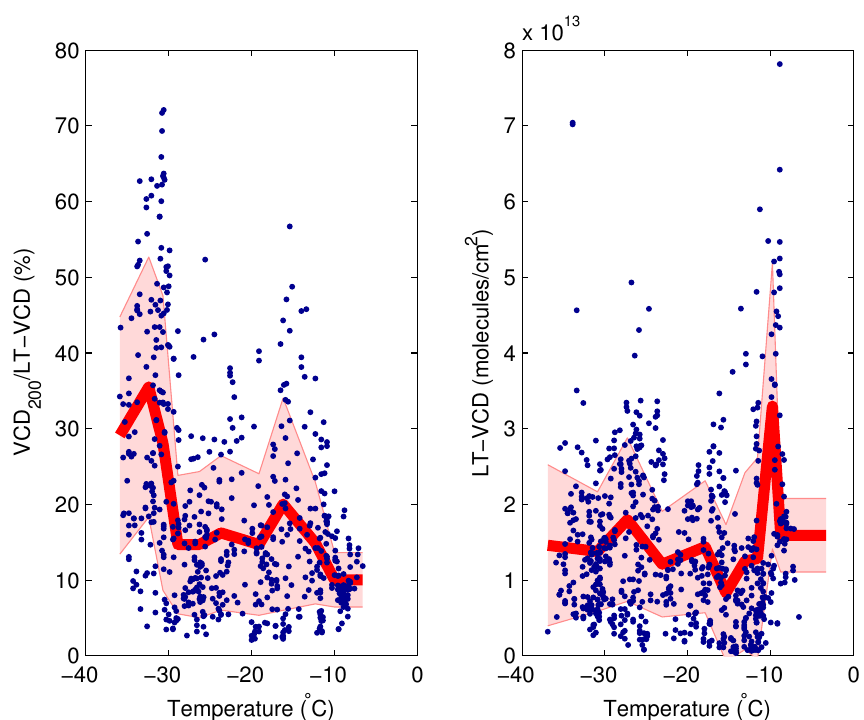
Figure 10. The relationship between BrO and temperature. The left panel shows the percentage of BrO in the lowest 200m vs. the near-surface temperature, while the right panel shows the LT-VCD vs. the near-surface temperature. The red line represents the mean, calculated from deciles on the x axis, while the shaded region represents 1 standard deviation. In the left panel, LT-VCD values below 5 × 10 12 moleculescm − 2 are eliminated to avoid calculating percentages from near zero amounts of